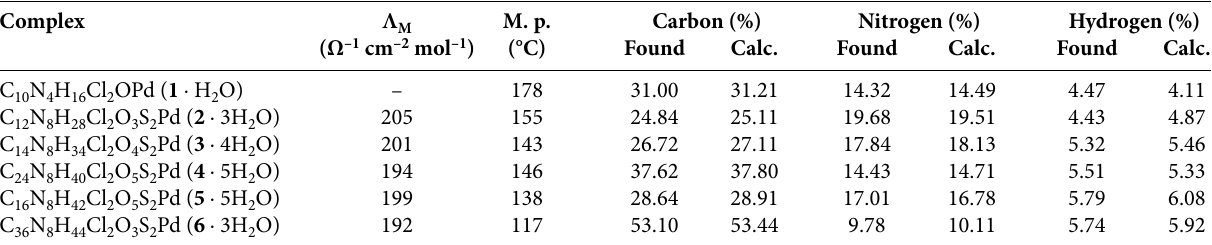
Table 1. Analytical and physicochemical data for the compounds 1 – 6 . Complex Λ M M. p. Carbon (%) Nitrogen (%) Hydrogen (%) (Ω –1 cm –2 mol –1 ) (°C) Found Calc. Found Calc. Found